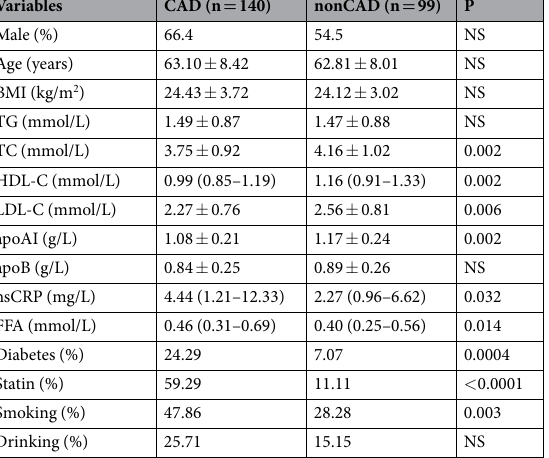
Table 1. Baseline characteristics of all the subjects. Values are expressed as mean ± SD or median (interquartile range). CAD indicates coronary artery disease; BMI, body mass index; TG, triglyceride; TC, total cholesterol; HDL-C, high density lipoprotein-cholesterol; LDL-C, low density lipoprotein-cholesterol; apoAI,